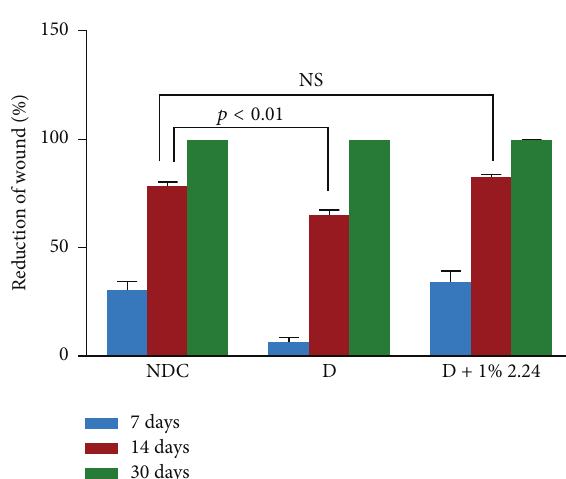
Figure 7: Healing (% reduction in diameter) of skin wounds in normal (NDC), diabetic vehicle-treated control (D), and diabetic topically treated with 1% CMC2.24 (D + 1% 2.24) rats, respectively, after 7 days, 14 days, and 30 days. Each value is the mean ± SEM for 18 measurements (3 rats/group) of 7 days and for 24 measurements (4 rats/group) of 14 days and 30 days.